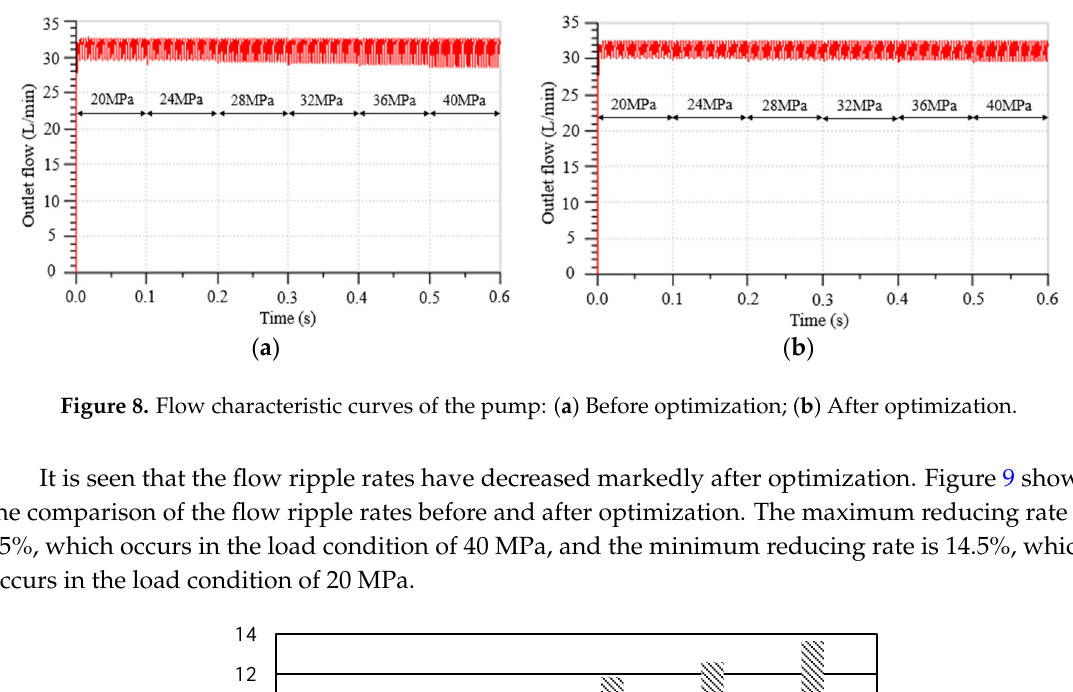
Figure 7. Iteration process of flow ripple: ( a ) 20 MPa; ( b ) 24 MPa; ( c ) 28 MPa; ( d ) 32 MPa; ( e ) 36 MPa; ( f ) 40 MPa.